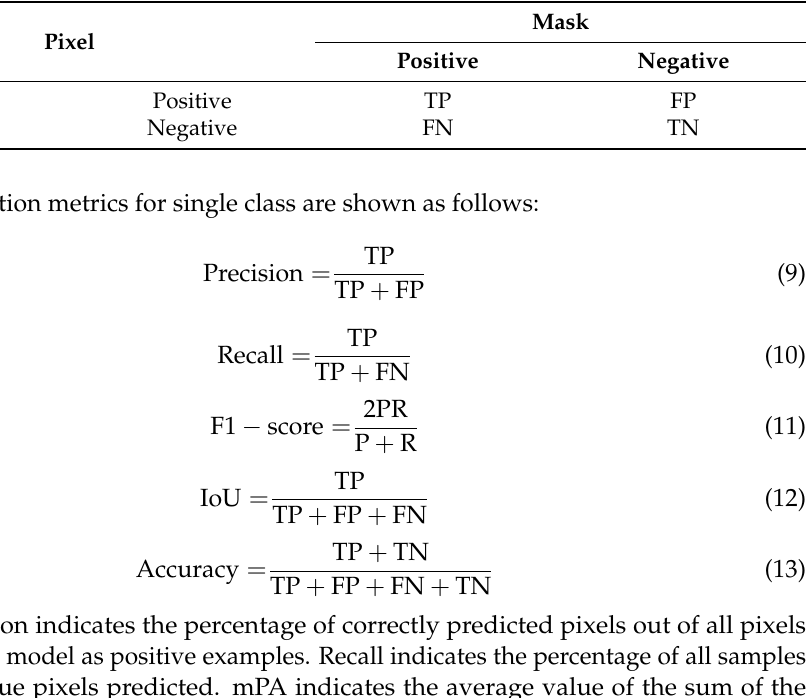
Table 2. The confusion matrix for evaluation.